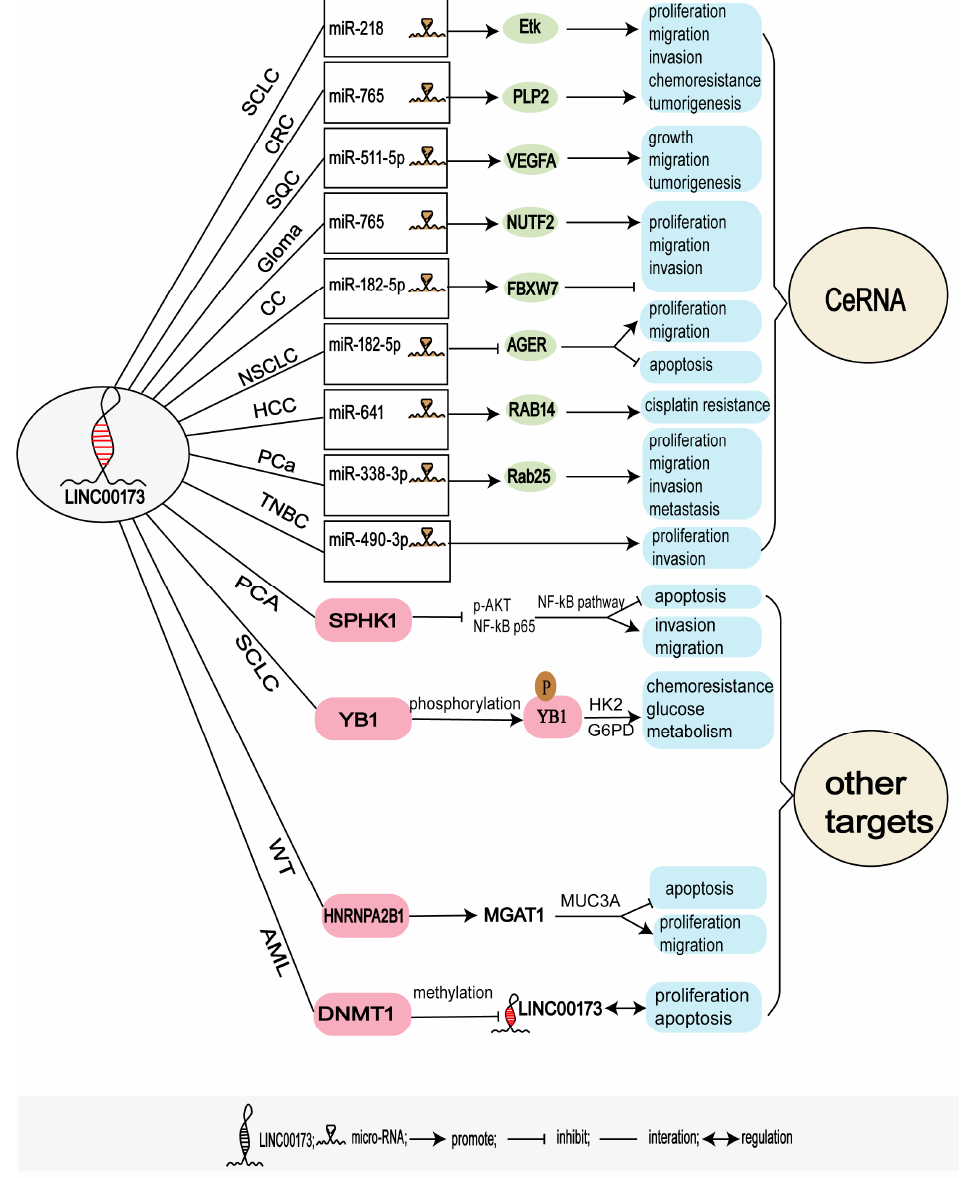
Figure 2. The regulatory targets related to LINC00173. LINC00173 interacts with 8 ceRNAs in 9 cancers and 4 other targets in 4 cancers.